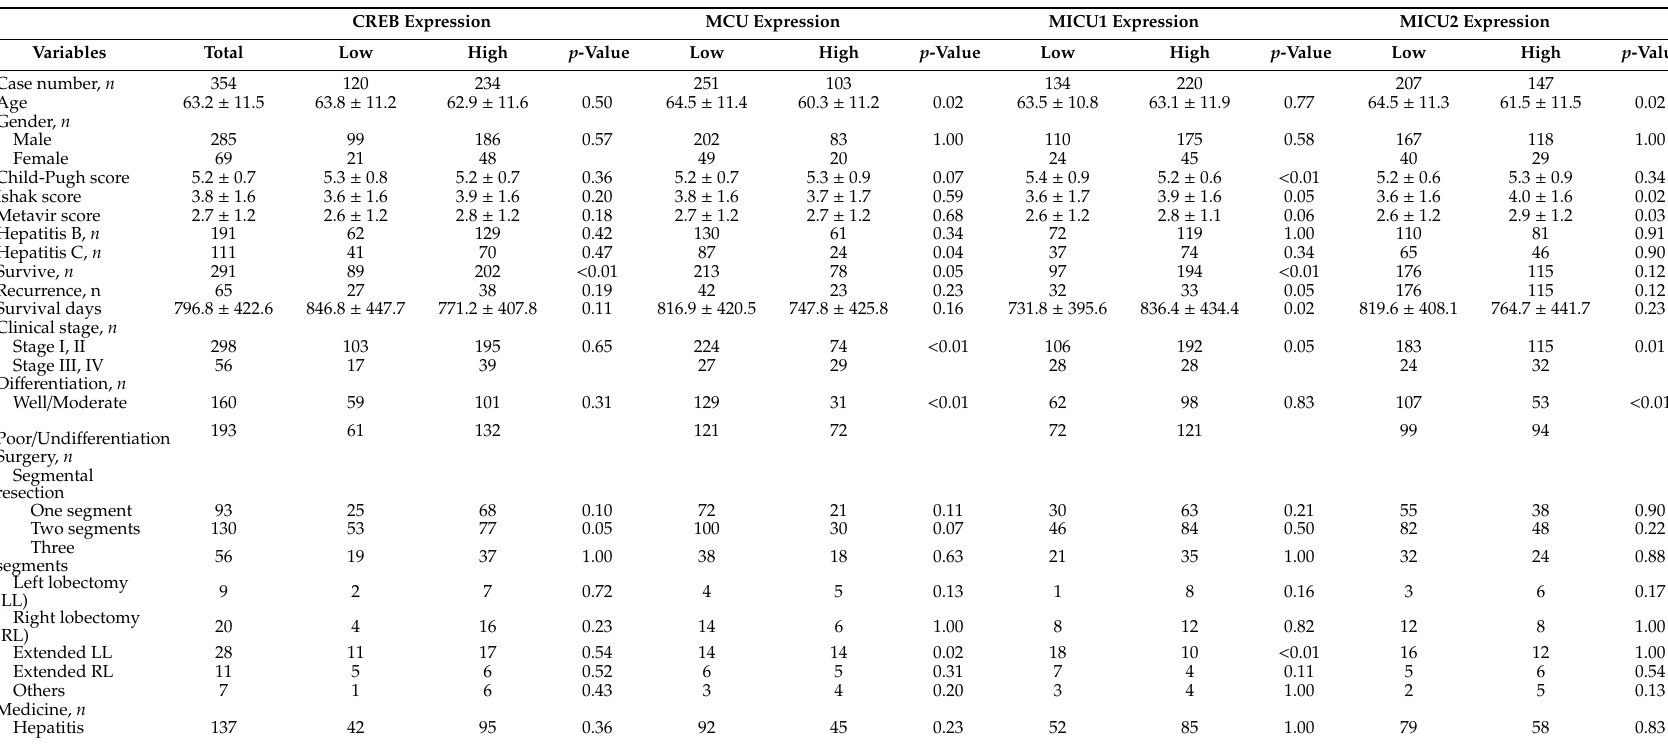
Table 1. The relationship of clinicopathological characteristics with cyclic adenosine monophosphate response element-binding protein (CREB), mitochondrial calcium uniporter (MCU), mitochondrial calcium uptake (MICU)1 and MICU2 expression in hepatocellular carcinoma (HCC) patients. CREB